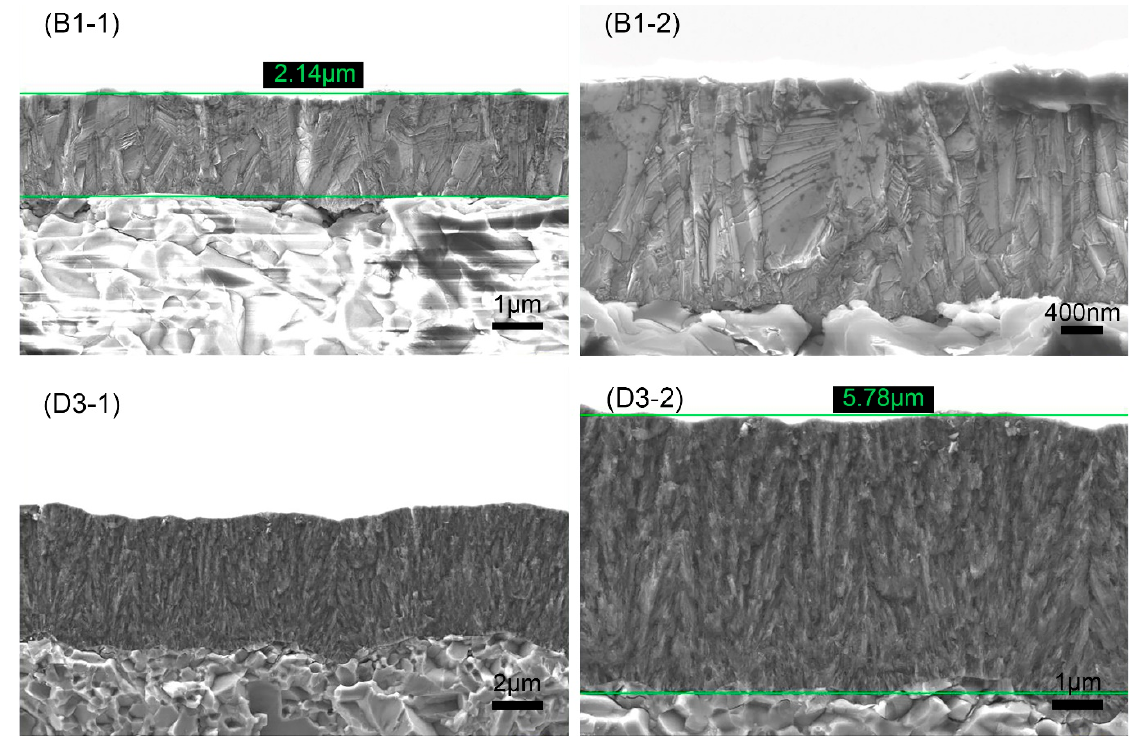
Figure 3. The cross-section morphology of MCD and NCD: ( B1-1 ) the magnification of B1 sample was 10,000 times; ( B1-2 ) the magnification of B1 sample was 20,000 times; ( D3-1 ) the magnification of D3 sample was 5000 times; ( D3-2 ) the magnification of D3 sample was 10,000 times.